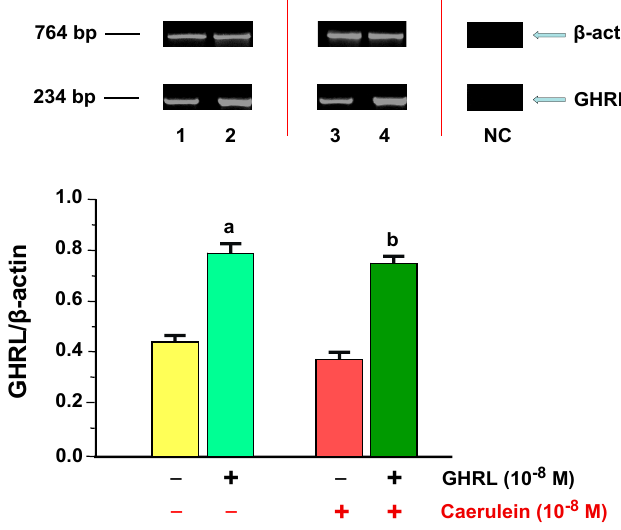
Figure 7. Analysis of ghrelin (GHRL) gene expression determined by reverse transcriptase-polymerase chain reaction (RT-PCR) and densitometric analysis of GHS-R1A/ β -actin mRNA ratio in AR42J cells: (line 1) control cells incubated in caerulein-and GHRL-free solution; (line 2) cells incubated in caerulein-free solution containing GHRL at a concentration of 10 − 7 M; (line 3) cells incubated in solution containing caerulein at a concentration of 10 − 8 M without addition of GHRL; (line 4) cells incubated in solution containing caerulein at a concentration of 10 − 8 M and GHRL at a concentration of 10 − 7 M. NC= negative control. Reference gene: β -actin. a p < 0.05 compared to control cells incubated in caerulein-and GHRL-free solution (line 1); b p < 0.05 compared cells incubated in solution containing caerulein without addition of GHRL (line 3). In each experimental group, the number of observations was at least 6.